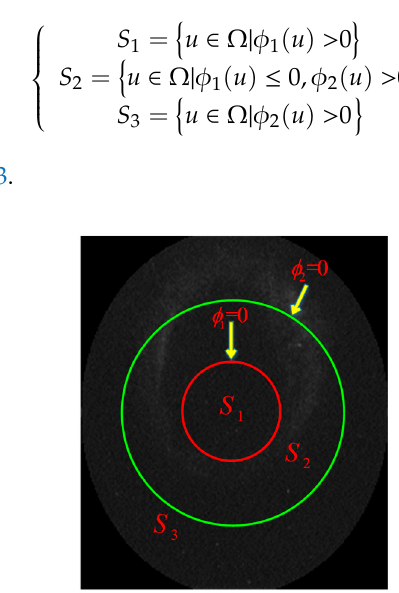
Figure 2. The flow diagram of the deep feature - based adaptive level set (DFALS) model.